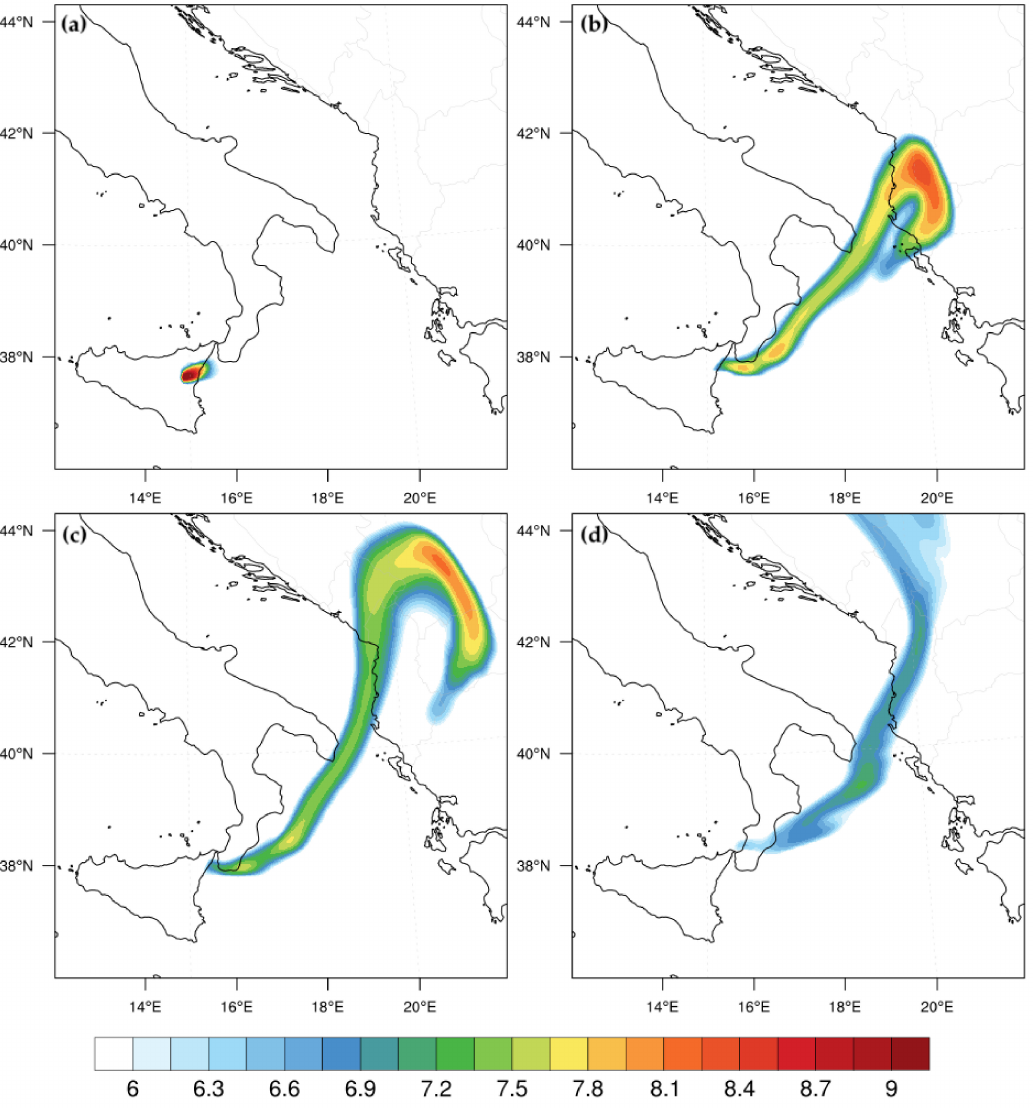
Figure A1. Snapshots of the WRF-Chem model output parameter Vash_col at ( a ) 10:00, ( b ) 14:00, ( c ) 16:00, and ( d ) 21:00 UTC on 23 November 2013. Contour lines are displayed at log 10 scale with µ g m − 2